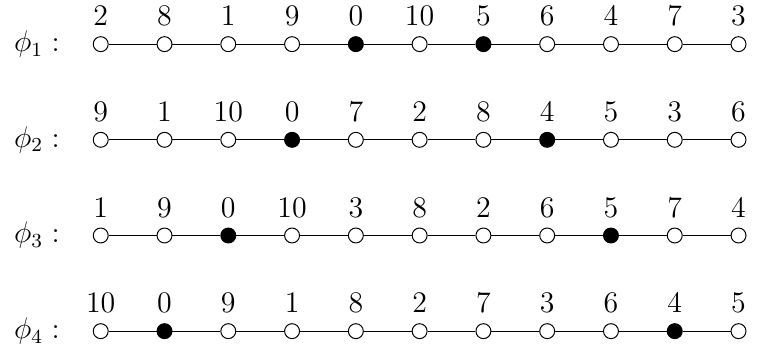
Figure 2: Different types of α -labelings of P